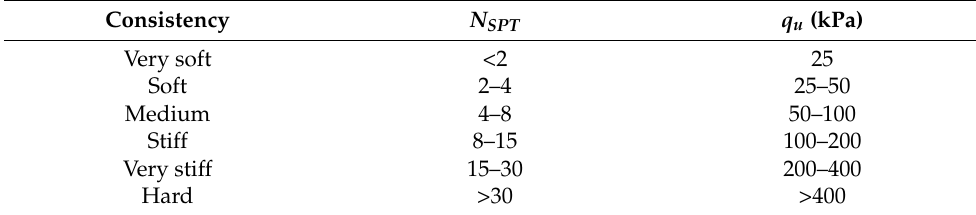
Table 1. The correlation between q u and N SPT [2].